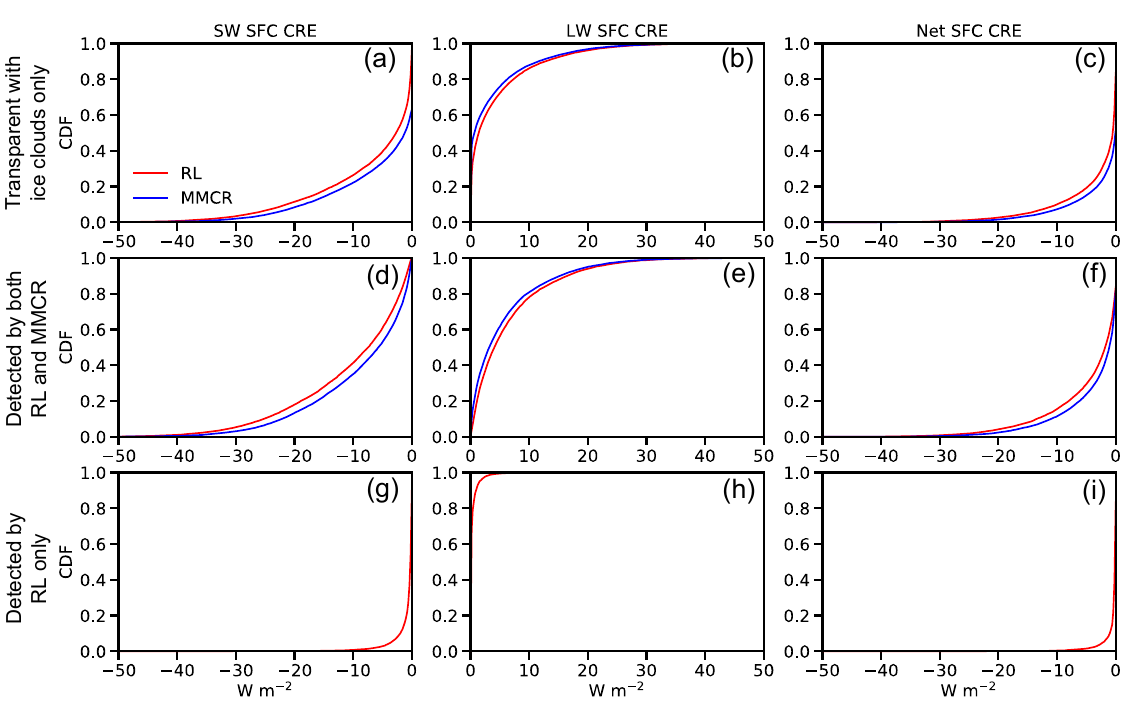
Figure 6. Same as Figure 5, but for the daily-mean cloud radiative effects (CREs) at the surface (SFC).